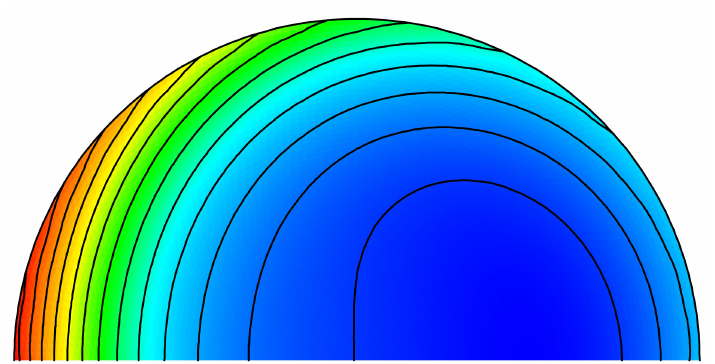
Figure 9. Contours of the current density magnitude.